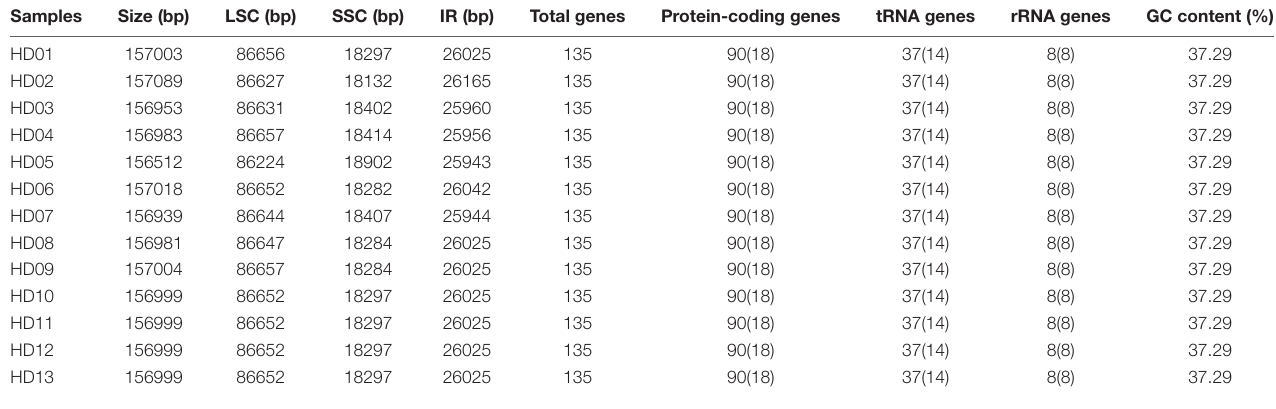
TABLE 3 | Comparison of chloroplast genome organization among 13